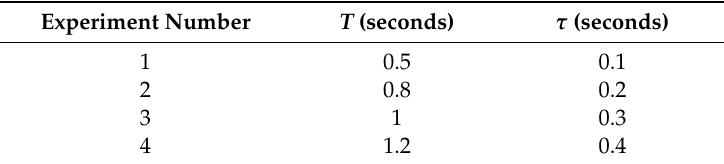
Table 8. Values about delay